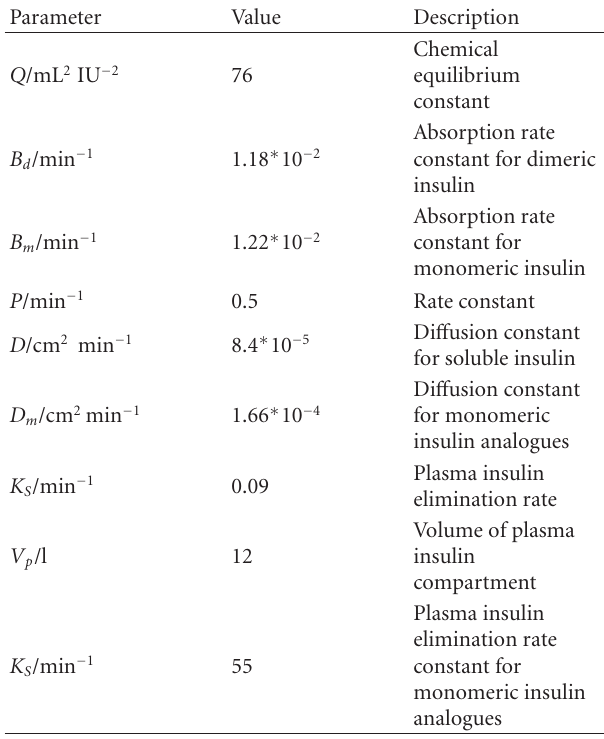
Table 3: Parameter set derived from Trajanoski et al.